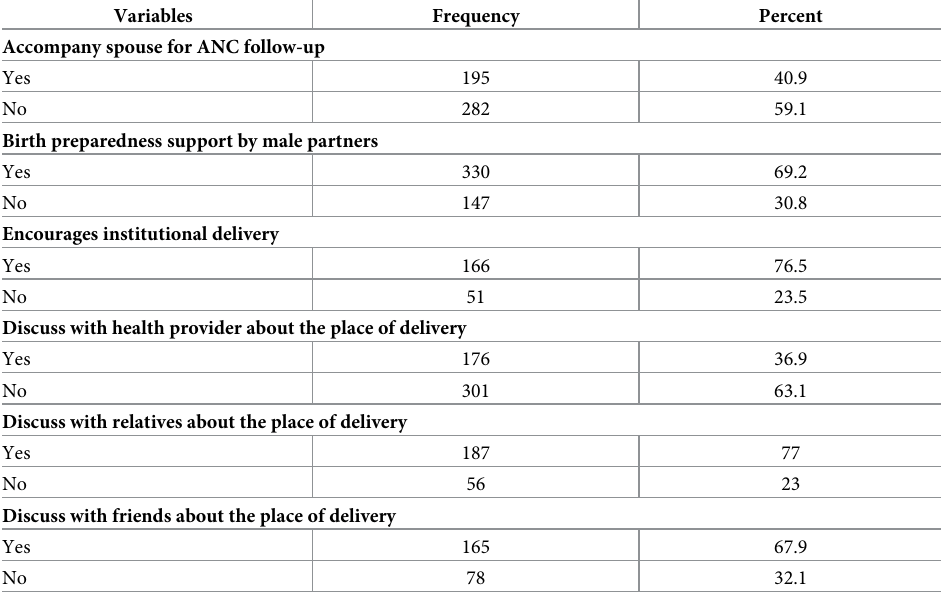
Table 4. Male partners involvement in institutional delivery in Debre Tabor town, North-West Ethiopia, 2019 (n = 477).